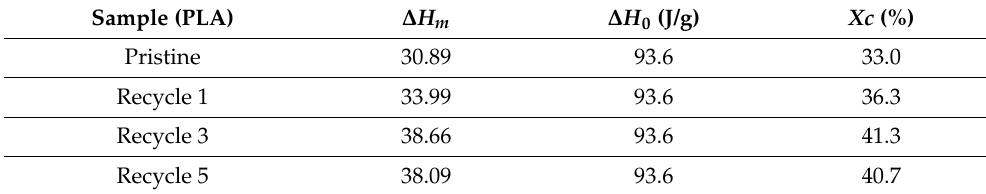
Figure 6. GPC results for pristine and recycled PLA filament. Table 1. Evaluating the thermal properties of PLA as a function of the recycling